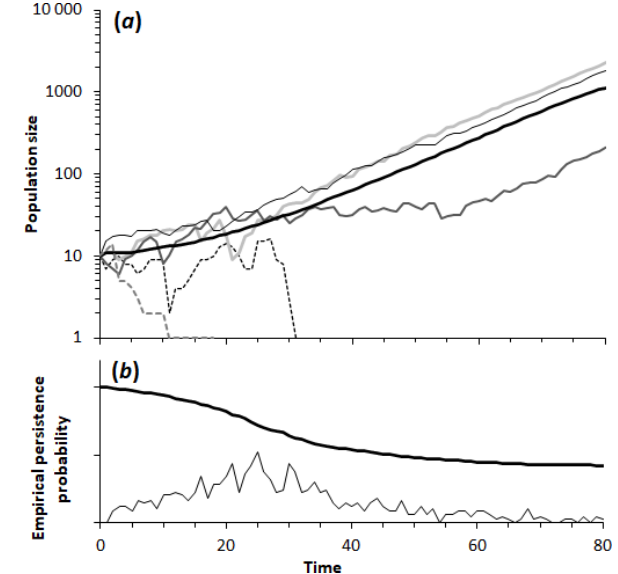
Figure 1. (a) Sample of five population trajectories as a function of time generated by the simulation model (using the same parame- ters), showing two extinctions and three iterations in which the pop- ulation persisted. The thick black line is the average of 1000 simula- tions. (b) Empirical persistence probability, based on the surviving populations (thick black line) and the number of new extinctions out of the 1000 simulated populations, both as a function of time. By t = 50 most populations have either gone extinct or reached a population sufficiently high that extinction is improbable. Param- eters: initial population is 10; impact of catastrophe is 10 deaths; average time interval between catastrophes is 10 years (95% inter- val is 0.253 to 36.9 years); carrying capacity is